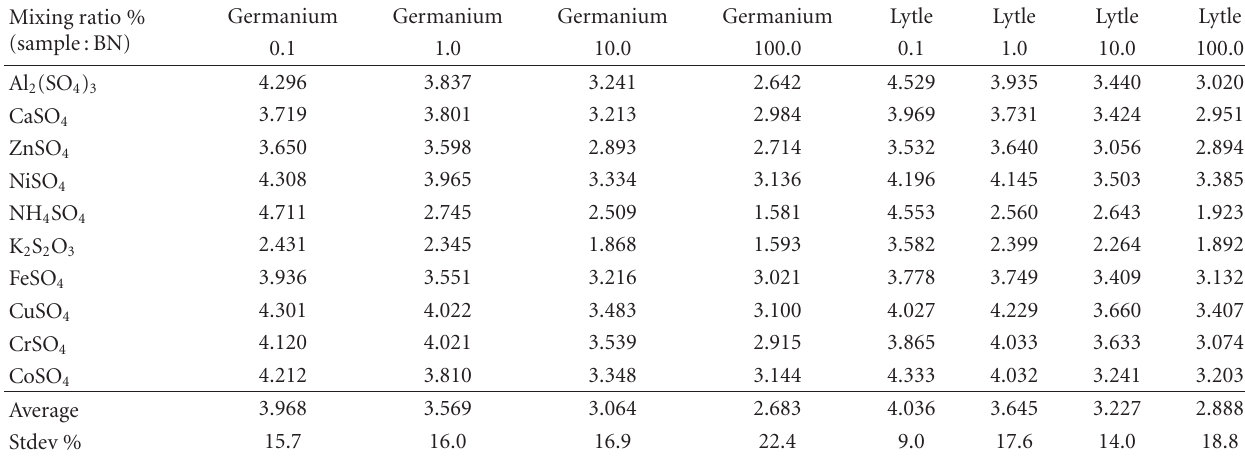
Table 2: Signal-to-noise ratios (S/N) of (NH 4 ) 2 SO 4 , CaSO 4 , Al(SO 4 ) 3 , MnSO 4 , ZnSO 4 ∗ 7H 2 O, K 2 S 2 O 3 , Cr 2 (SO 4 ) 3 ∗ 15H 2 O, CoSO 4 ∗ 7H 2 O,